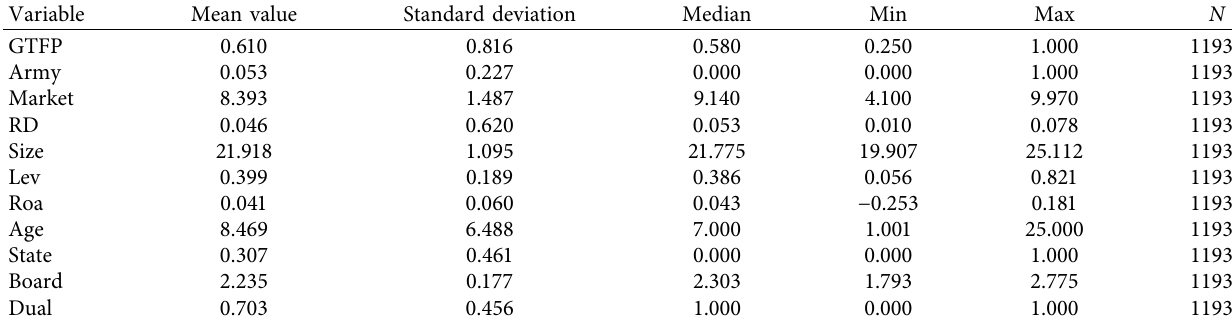
Table 2: Descriptive statistics.